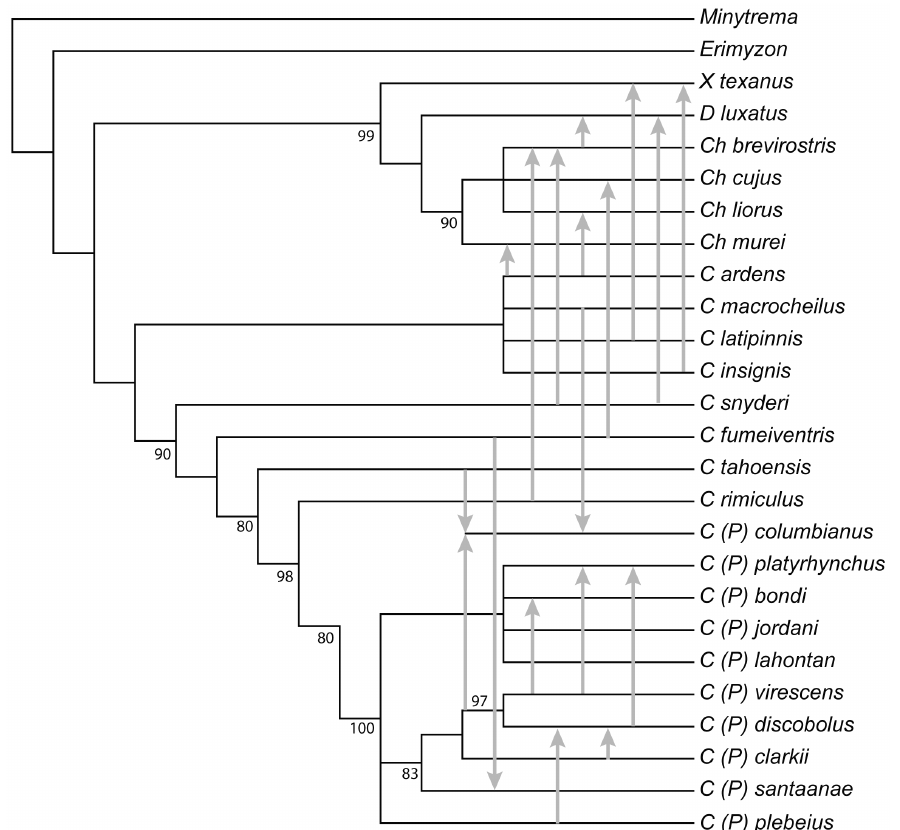
Figure 4. Morphology-based phylogenetic tree based on PAUP analysis of 87 characters of Pantosteus and other catostomin species from the genera Xyrauchen , Deltistes , Chasmistes , and Castostomus . Arrows indicate introgression of mtDNA and morphological traits (modified from [20]). Topology is based on the strict consensus of 63 equally shortest maximum parsimony trees (length=252, CI=0.53, RI=0.83). Bootstrap values of . 80 and above shown at nodes (from 1000 replicates).